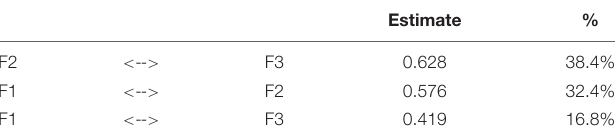
TABLE 3 | Correlations between